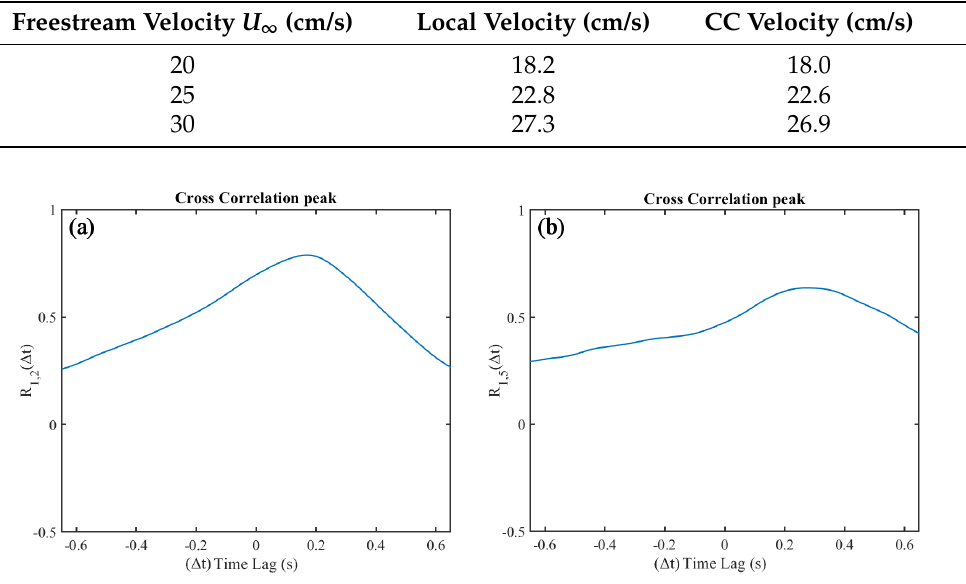
Figure 6. Typical profiles of the cross-correlation function around the peak for tunnel flow speed at 20 cm/s. ( a ) CC of whiskers w1 and w2, peak value of 0.78. ( b ) CC of whiskers w1 and w5, peak value of 0.62. The greater time delay in B) is due to the lower velocity, as discussed